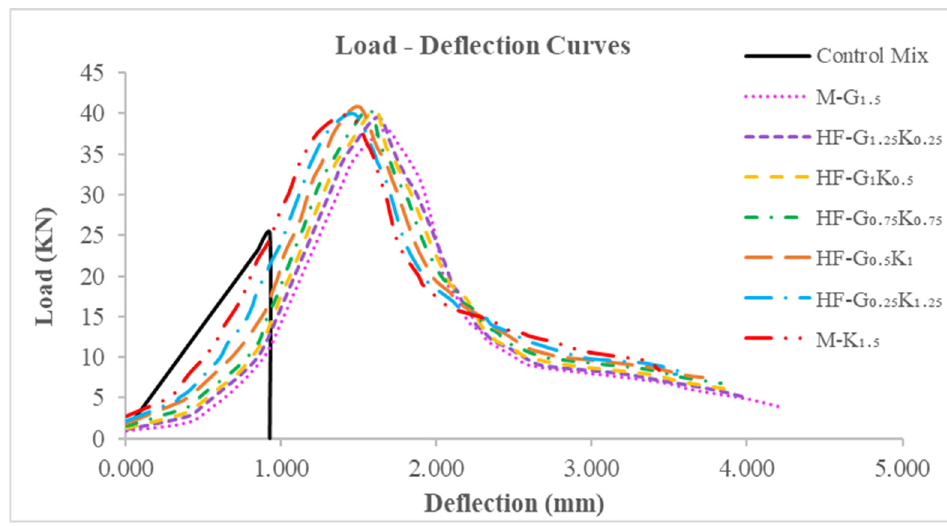
Figure 8. Load–deflection curves of concrete specimens.